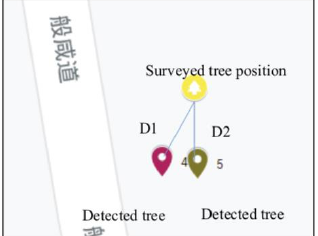
Figure 15. Calculation of mean planimetric deviation w.r.t.